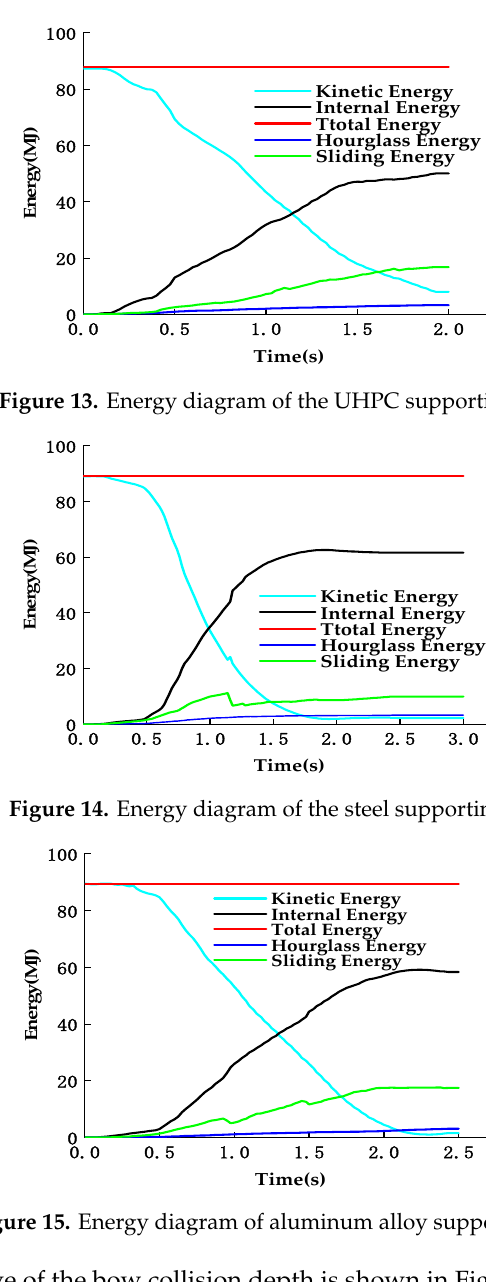
Figure 16. Bow impact depth time-history curve . 0.0